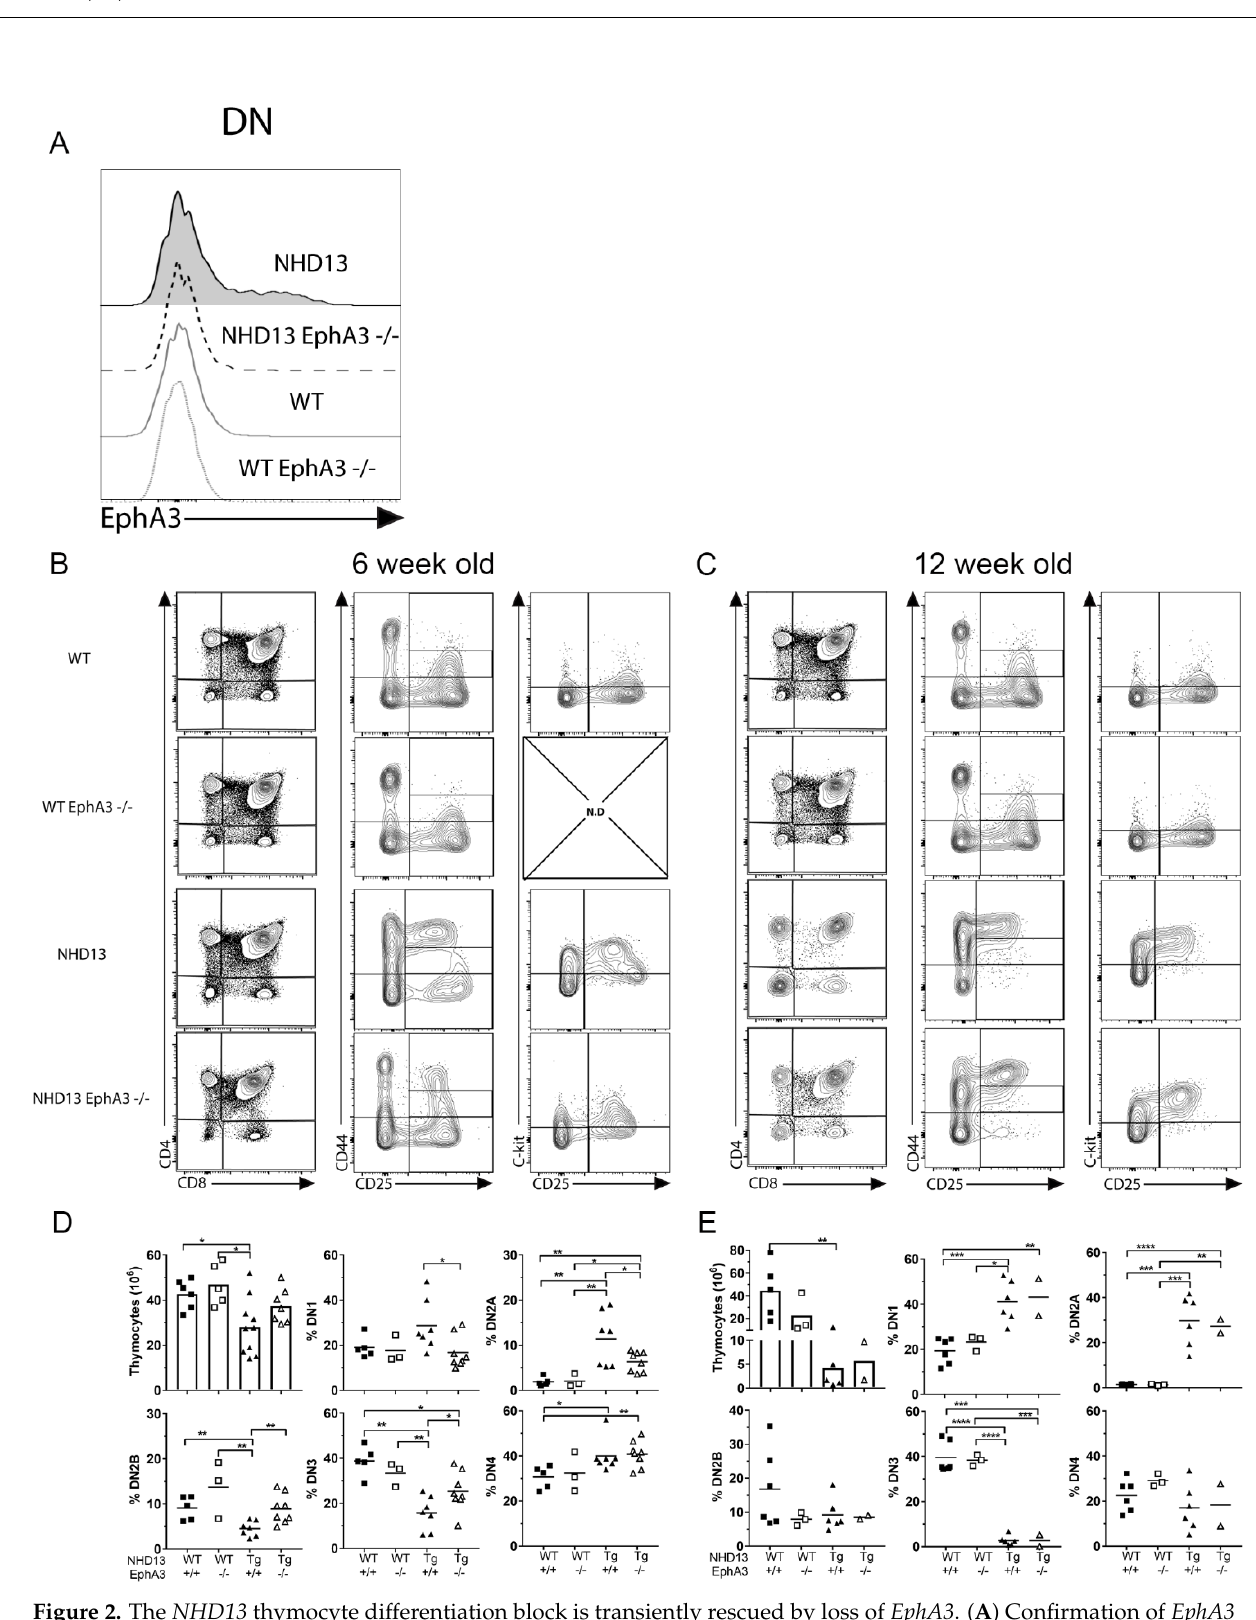
Figure 2. The NHD13 thymocyte differentiation block is transiently rescued by loss of EphA3 . ( A ) Confirmation of EphA3 deletion in DN (CD4 − /CD8 − ) thymocytes by flow cytometry. ( B ) Representative thymocyte profiles using CD4/CD8, CD44/CD25, and C-KIT/CD25 for each indicated genotype in 6-week-old and ( C ) 12-week-old mice. ( D ) Quantitation of thymic cellularity and proportions of DN1, DN2A, DN2B, DN3, and DN4 in 6-week-old and ( E ) 12-week-old mice. Data represent the mean, while points represent individual mice (3–8 per group). p -values were calculated using Student’s t -test (* p < 0.05, ** p < 0.005, *** p < 0.0005, **** p < 0.00005). N.D.: not